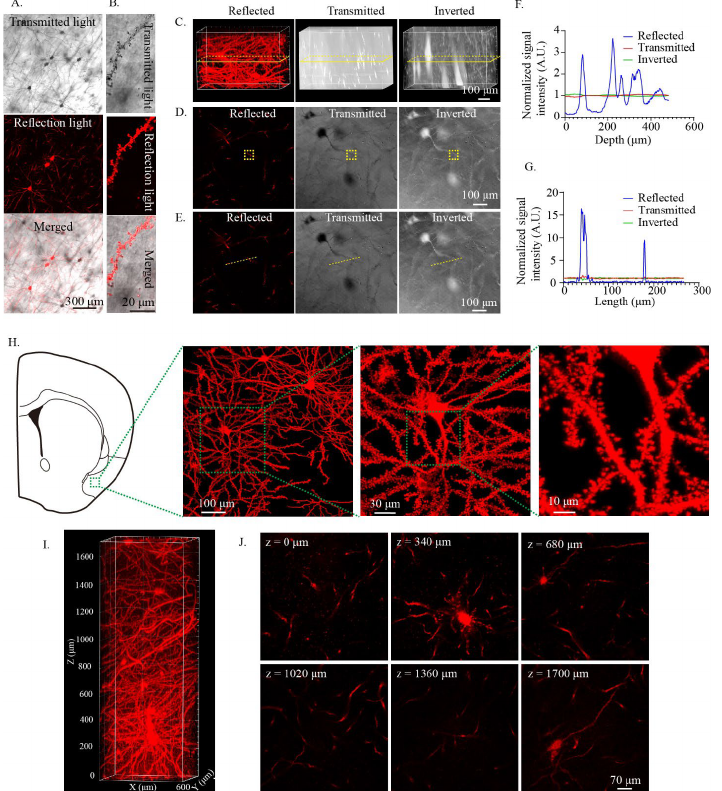
Figure 2. Three-dimensional imaging of cleared Golgi-stained tissue using the confocal reflective mode. ( A ) Imaging of the cleared Golgi-stained neuronal cell bodies and fibers using transmitted light and reflection light with confocal microscopy. ( B ) Imaging of the Golgi-stained dendritic spines after clearing using transmitted light and reflected light with confocal microscopy. ( C – G ) Imaging of cleared Golgi-Cox-stained tissue using confocal reflective mode increases spatial resolution. ( C ) Three-dimensional rendering of the same position of cleared Golgi-Cox-stained tissue with confocal reflective mode (reflected) and transmitted light (transmitted). The images obtained by transmitted light were inverted (inverted) and 3D rendered to facilitate visualization. The inserted yellow rectangle is the region of interest for the analysis of the signal intensity in ( D , E ). ( D ) Sectional image from ( C ). The inserted yellow rectangle was the region of interest for the analysis of the signal intensity through the z-axis. ( E ) Sectional image from ( C ). The inserted yellow line was the region of interest for the analysis of the signal intensity through xy plane. ( F ) Analysis of the normalized signal intensity through the z-axis. The normalized signal intensity was calculated with the formula: signal value/average signal value. ( G ) Analysis of the normalized signal intensity through the xy plane. The normalized signal intensity was calculated with the formula: signal value/average signal value. ( H ) Three-dimensional imaging of the fine morphology of cleared Golgi-stained tissue showing the neuronal cell bodies, fibers, and dendritic spines. The samples were cleared with modified MAP and incubated in PBS. The images were obtained with a 20 × 0.8 NA air objective lens. ( I , J ) Three- dimensional imaging of larger-volume cleared Golgi-stained tissue. ( I ) Three-dimensional rendering of the cleared Golgi-stained tissue. One millimeter thick slices were used for clearing and imaging (about 2 mm thick after clearing and incubating in PBS). ( J ) Sectional images at different